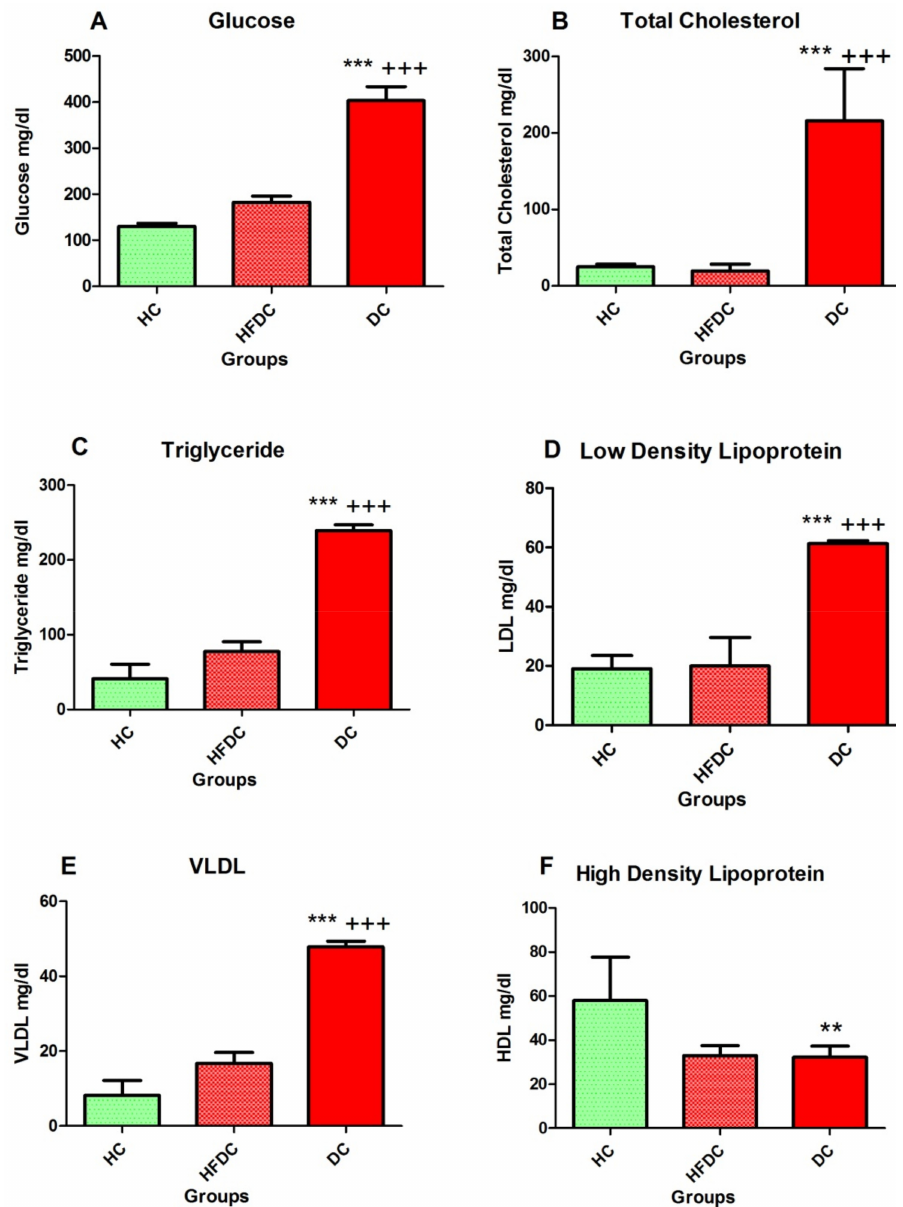
Figure 2. Diabetic rats showed elevated serum glucose and lipid profile. ( A ) Serum glucose levels; ( B ) Serum total cholesterol levels; ( C ) Serum triglyceride levels; ( D ) Serum low density lipoprotein levels; ( E ) Serum VLDL levels; ( F ) Serum high density lipoprotein levels. Results are recorded as a mean of three replicates and denoted as mean ± SD ( n = 6 animals per group). ** p ≤ 0.01 and *** p ≤ 0.001, healthy control group; +++ p ≤ 0.001, HFD control group; (Dunnett’s Multiple Comparisons Test). HC: Healthy control, HFDC: High fat diet control, DC: Diabetes control. VLDL: Very low-density